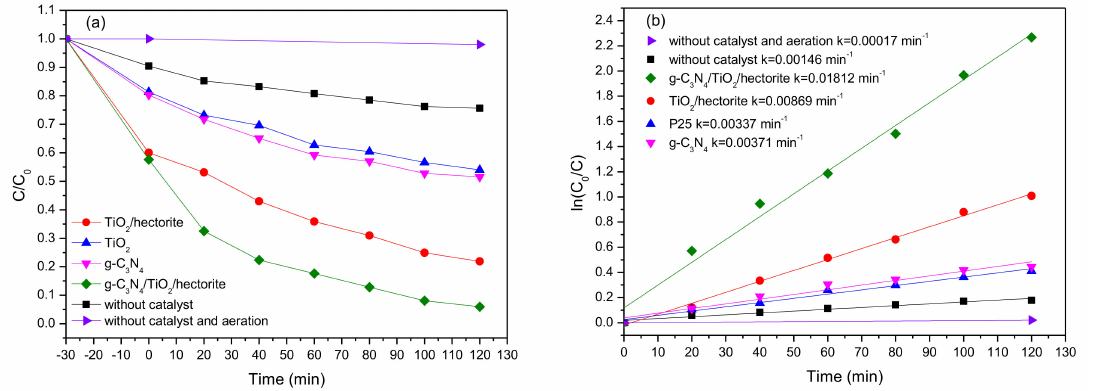
Figure 7. ( a ) Photocatalytic degradation of f rhodamine B (RhB) under visible light; ( b ) kinetic curves of RhB under visible